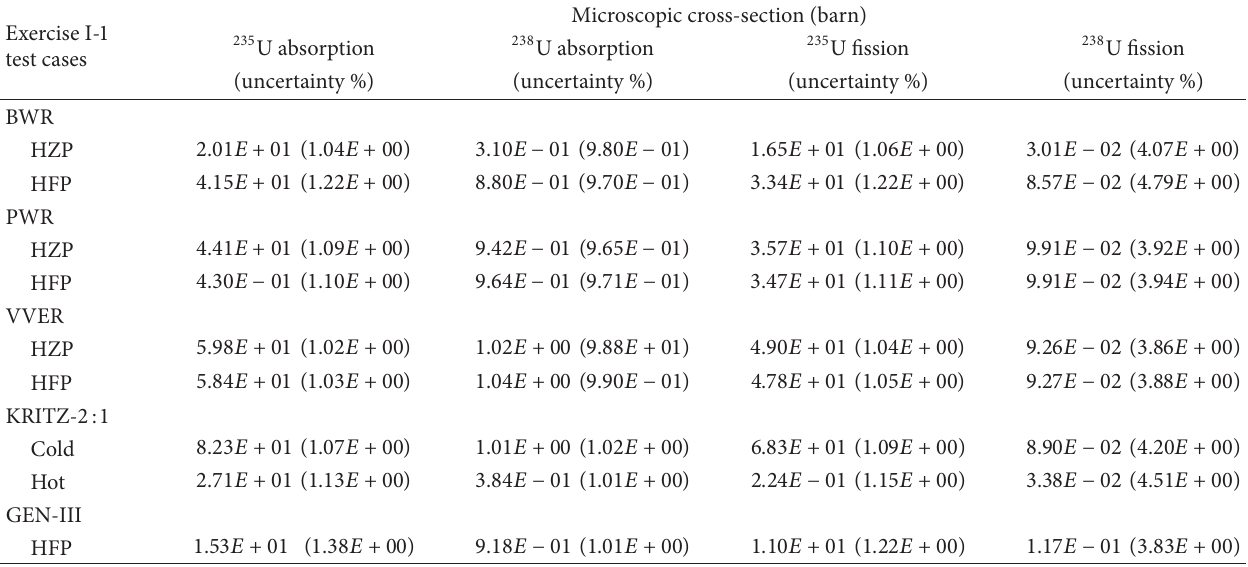
1.1𝐸𝐸𝐸 𝐸 01 𝐸𝐸.𝐸𝐸𝐸𝐸 𝐸 00𝐸